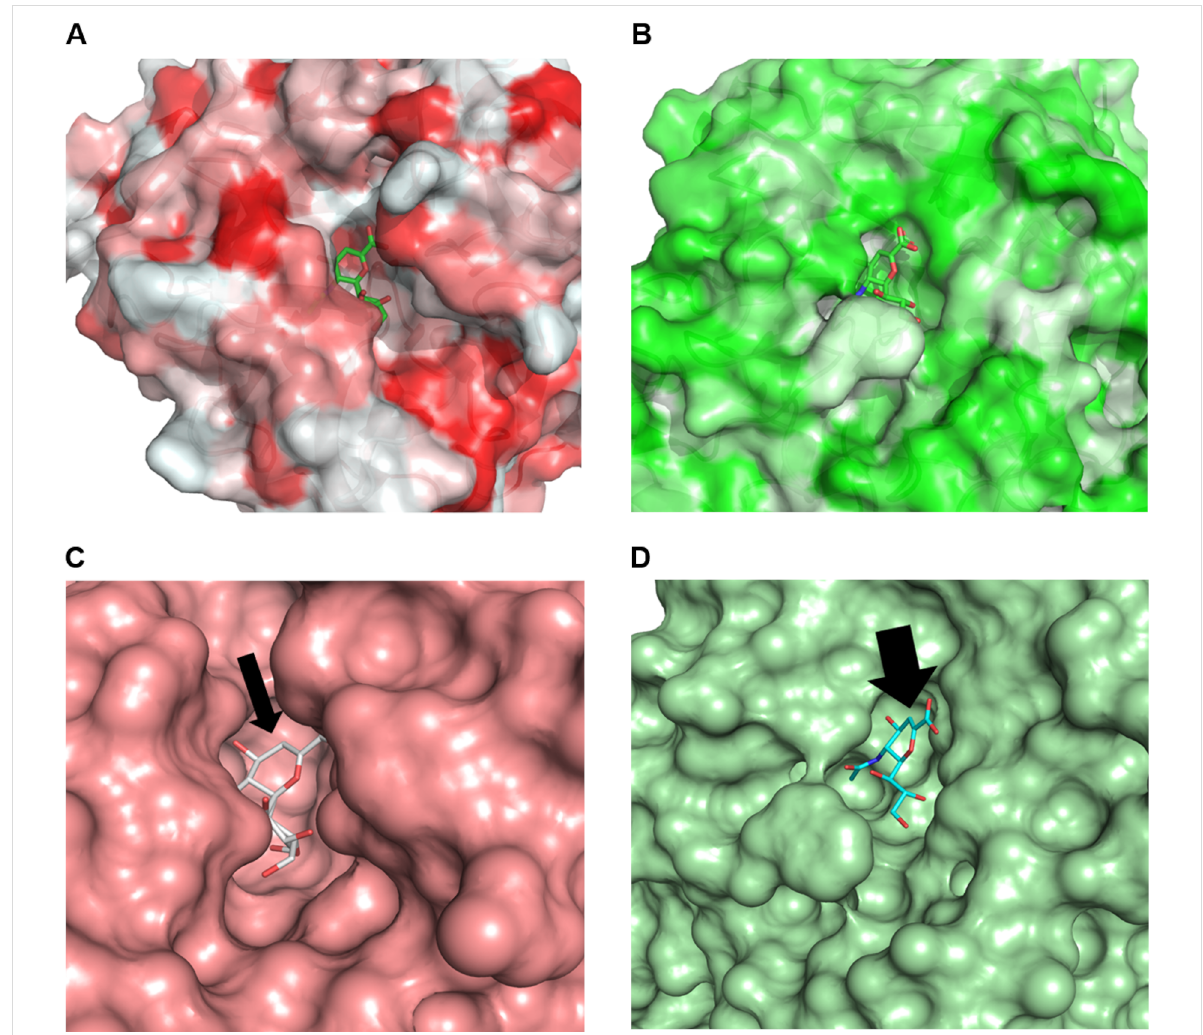
Figure 5: Crystal structure of TcTS (PDB code 1MS1 – coloured red) (A) and neuraminidase (PDB code 2VK6 – coloured green) (B) in complex with DANA showing a bulky hydrophobic loop that sits over TcTS active site in its absence for neuraminidase. The black arrows indicate the difference be- tween the narrow (TcTS) (C) and wide (neuraminidase) (D) regions around C-2 in both active sites, possibly preventing the inhibitors from entering the TcTS active site due to steric hindrance.